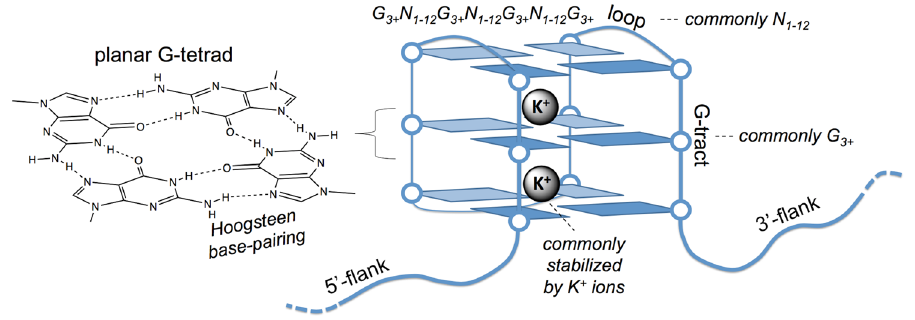
Figure 1. Schematic representation of features of canonical G-quadruplex (G4) structures in DNA, along with a common sequence motif used to identify such structures. The structure comprises four tracts of guanines (G-tracts) that form planar G-tetrads through Hoogsteen base-pairing.